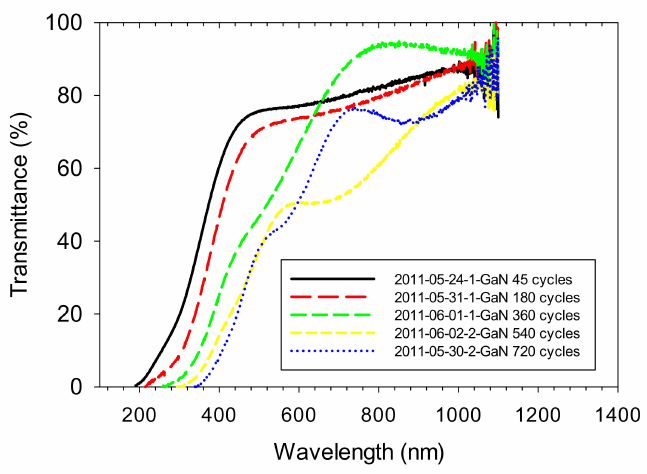
Figure 5. Optical transmission spectra for the sample in Figure 4 grown for 45 cycles and for four other samples grown with an increasing number of cycles. All samples were etched with HCl solution to remove excess surface gallium before